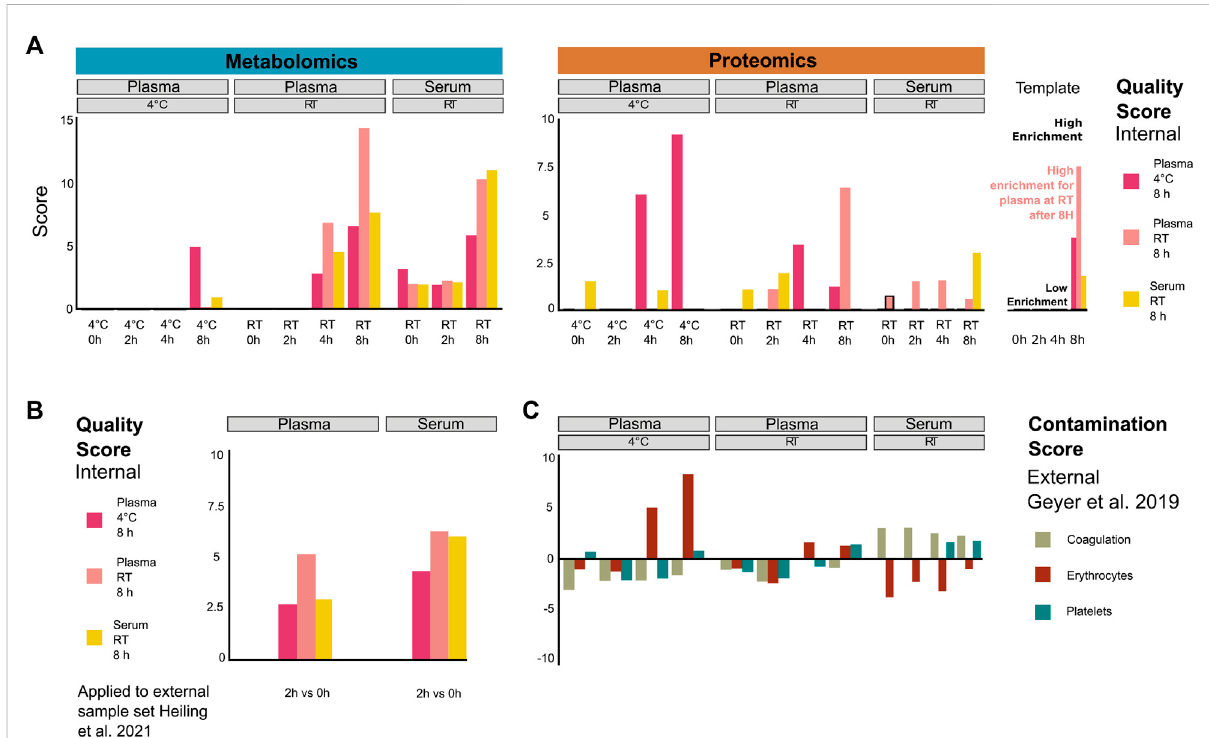
Systematic evaluation of sample quality and contamination with proteomic and metabolomic signatures. (A) Proteomic/metabolic pre- analytical condition signature scores for each sample group (as averaged from individual samples). Signature scores are normalized enrichment scores, representing the number of standard deviations away from the mean of an empirical null distribution of scores. A high score means that the sample displays anenrichmentofmarkersof thecorresponding signature compared to othersamples. Whilethescores generatedcan beboth positive and negative, we focus exclusively on positive scores in this fi gure. (B) Metabolic pre-analytical signature applied to score samples from an external study (Heiling et al., 2021). (C) Coagulation, erythrocyte, and platelet signatures were used to score the contamination of proteomic plasma and serum samples. Signatures were taken from Geyer et al.